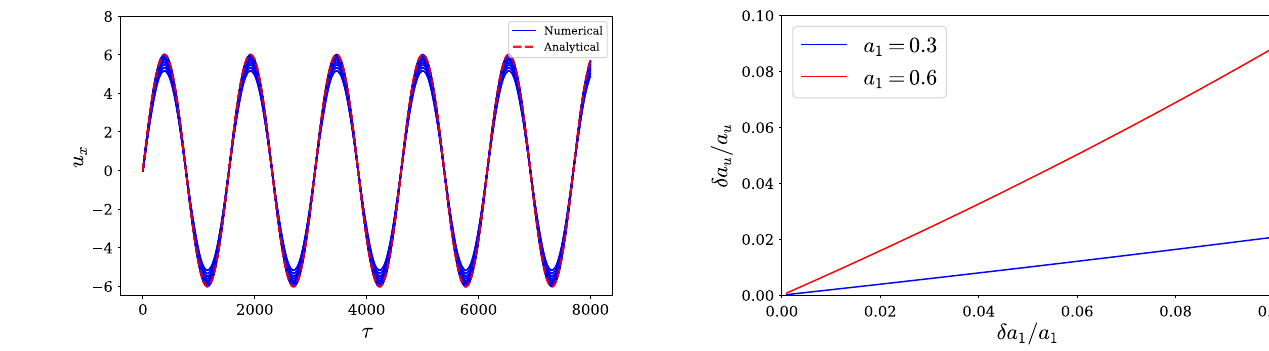
in ˆ x direction. Red FIG. 5. Variation of the undulator strength with different x laser pulse strength: read solid line with a 1 ¼ 0 . 6 ; blue solid line with a 1 ¼ 0 . 3 . The parameters are chosen as: plasma 1 μ m density 10 18 cm − 3 , wavelength of the laser pulse λ L ¼ 1 . 14 , gamma factor of the injected and laser spot size r m ¼ electron γ 0 ¼ 1000